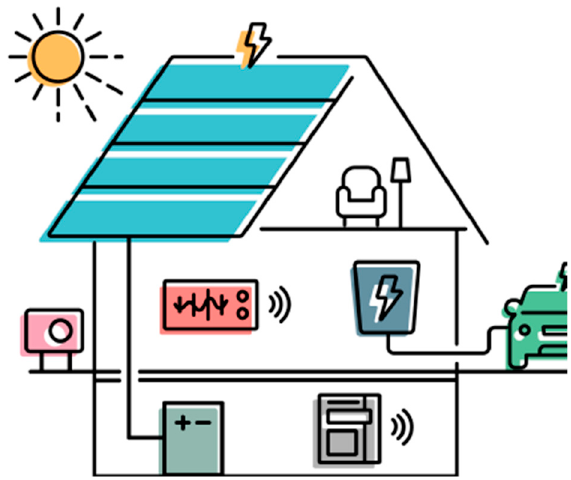
Figure 20. Smart house concept from [131].